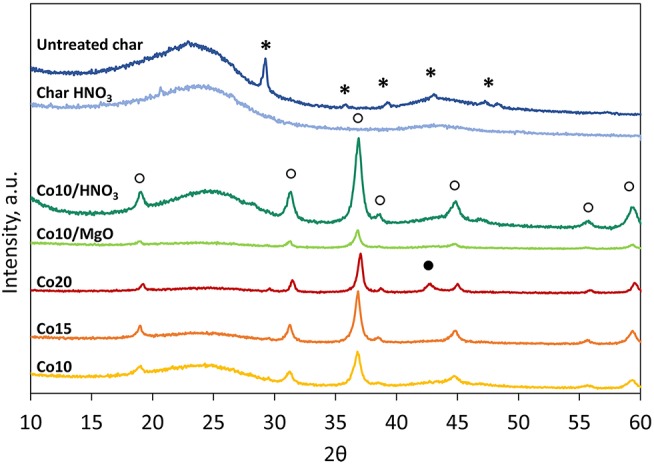
XRD patterns of supports and calcinated catalysts (*, CaCO3; ◦, Co3O4; •, CoO).